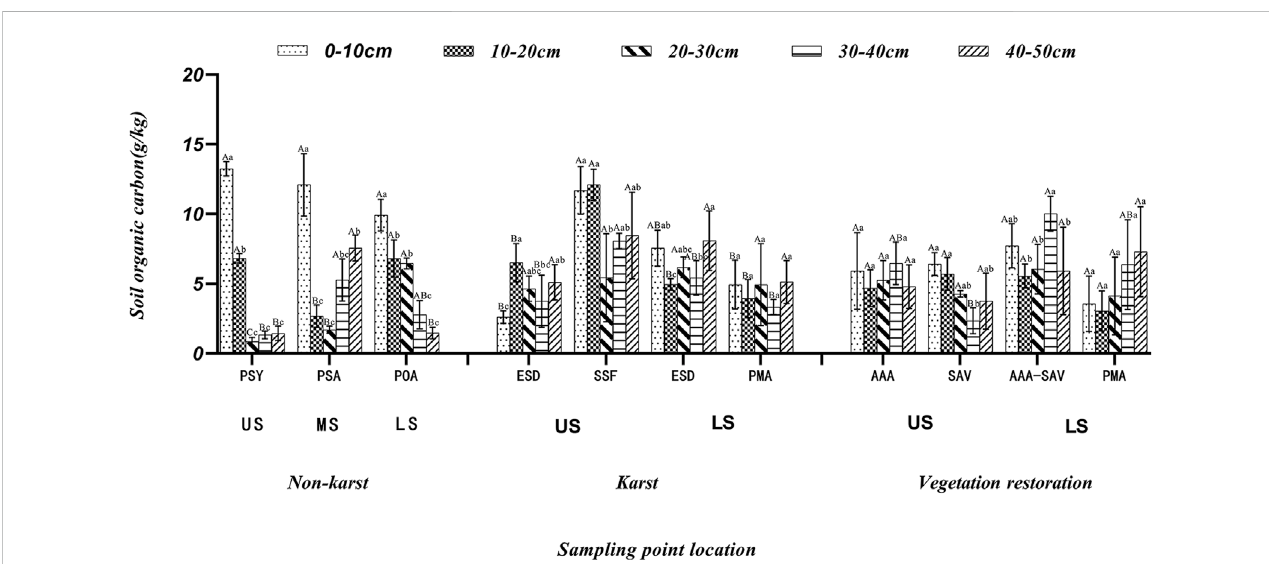
FIGURE 2 Content distribution characteristics of SOC in different bands. Capital letters represent signi fi cant differences between different depths in the same region, and lowercase letters represent signi fi cant differences between different regions at the same depth. PSY:Pinus Yunnanensis; PSA:Phyllostachys sulphurea; POA:Plantago asiatica; ESD:Elymus dahuricus; SSF:Sporobolus fertilis; PMA:Pennisetum alopecuroides; AAA:Artemisia argyi; SAV: Setaria viridis; AAA- SAV: Artemisia argyi- Setaria viridis; US: Upper-slope; MS: Middle-slope; LS: Lower-slope (Similarly